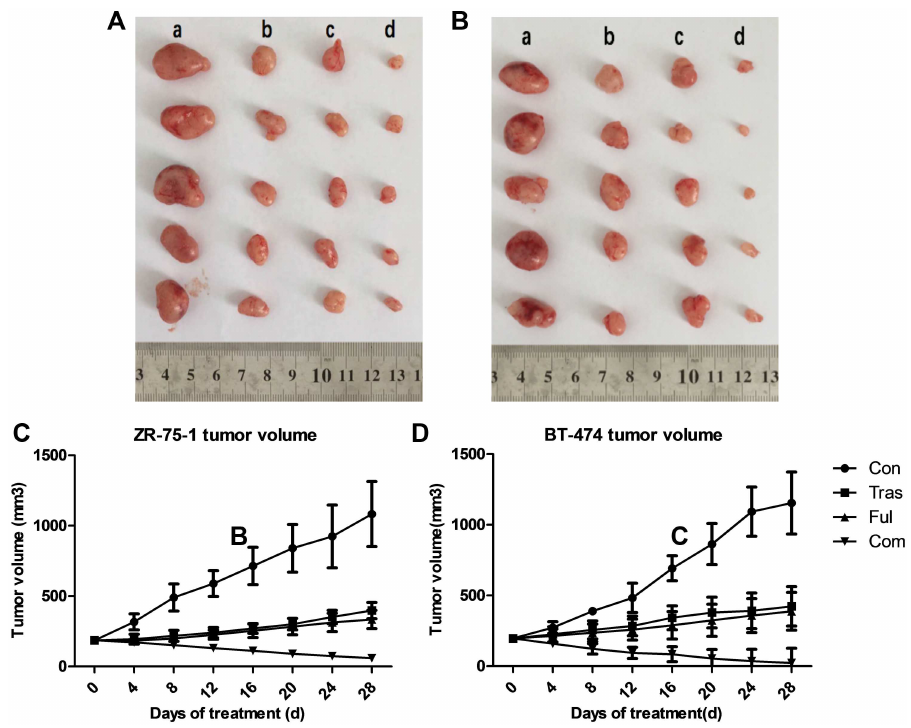
Fig 8. Nude Mouse Xenograft Model Studies. ZR-75-1 (a) and BT-474 (b) tumor xenografts excised from female BALB/c (nu/nu) nude mice after four-week treatments with trastuzumab and fulvestrant as single agents or in combination. Days versus tumor volume curves for ZR-75-1 (c) and BT-474 (d) tumor xenografts show that trastuzumab and fulvestrant as single agents or in combination significantly inhibitedtumor growth ( P < 0.05)and that tumor growth in the combination group was notablymuch more inhibitedcomparedwith that in individually treated groups ( P < 0.05).